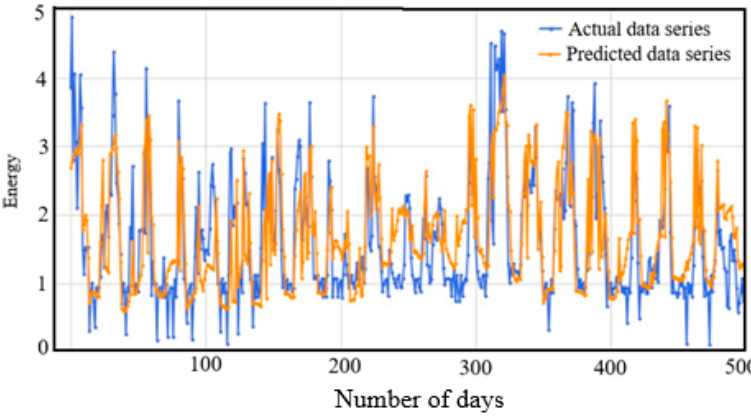
Figure 12. Prediction performance of the proposed model for the AEP dataset.